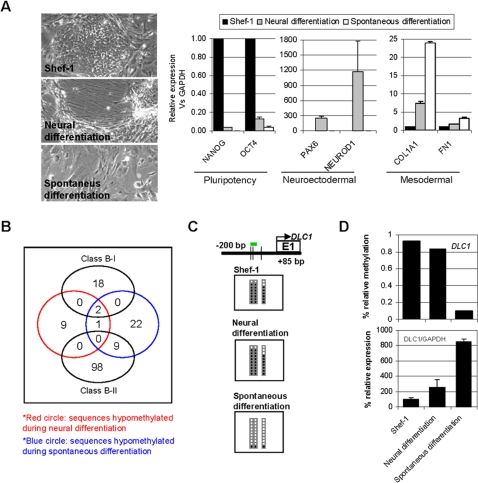
Loss of promoter DNA methylation during in vitro differentiation of hESCs.(A) Left-hand images, Shef-1 stem cell line (upper) and the same cells after neural differentiation (middle) and spontaneous differentiation to fibroblast-like cells (lower). The right-hand panels show the relative mRNA levels of pluripotency (NANOG, OCT4), neuroectodermal (PAX6, NEUROD1), and mesodermal (COL1A1, FN1) markers before and after Shef-1 differentiation. (B) Number of sequences hypomethylated during Shef-1 neural (red circle) and spontaneous (blue circle) differentiation, and their overlap with Class B-I and Class B-II genes (black circles). (C) Bisulfite genomic sequencing of multiple clones of the DLC1 promoter in Shef-1 stem cell line (upper) and the same cells after neural differentiation (middle) and spontaneous differentiation to fibroblast-like cells (lower). The color code is as for Figure 2. (D) Relationship between DLC1 promoter hypermethylation and expression during differentiation of Shef-1 cells. The upper panel shows the relative methylation signal obtained with the methylation arrays and the lower panel the expression levels of DLC1 mRNA relative to GAPDH.